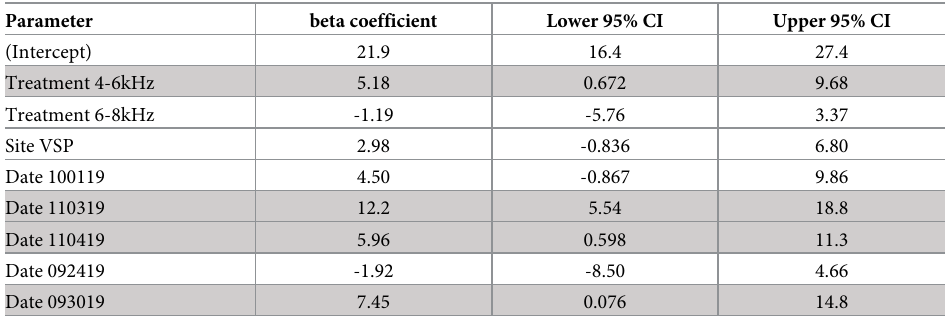
Subset of all model-averaged parameter estimates based on a-priori interest and parameter importance. Treatment refers to the effects of the two sound ranges. Site refers to the VSP tower location. Date refers to the date (month-day- year) of observations. Parameter estimates with 95% confidence intervals not overlapping zero are highlighted in gray.